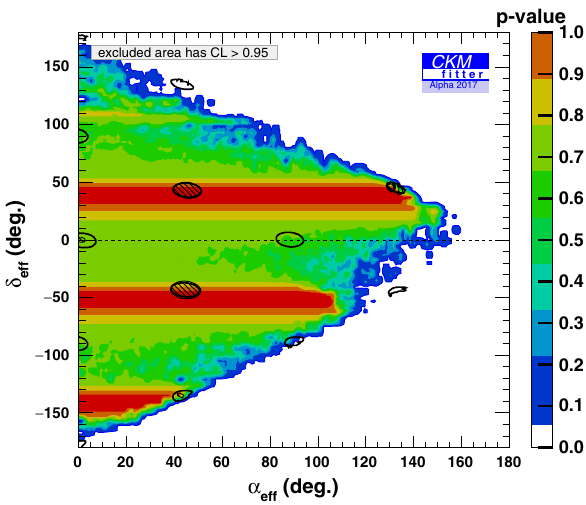
Fig. 37 Two-dimensional constraint in the ( α eff , δ eff ) plane. The coloured area is obtained from the interference-related coefficients U ± I m ( R e ) +− only. The black ellipses come from the Q2B coefficients { U i , I } j i , j = ( + , − ) . The shaded ellipses result from considering the j whole U and I data set for B 0 → (ρπ) 0